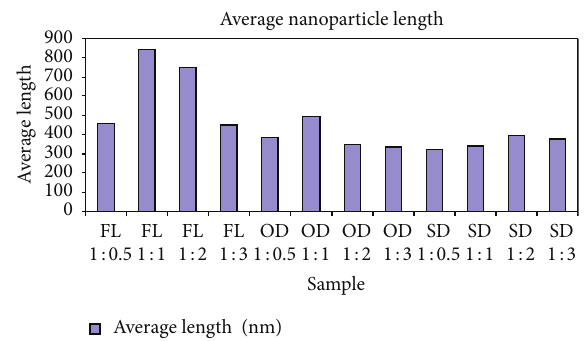
Figure 8: Average area of silver nanoparticles synthesized from the leaf extracts of Pimenta dioica under different